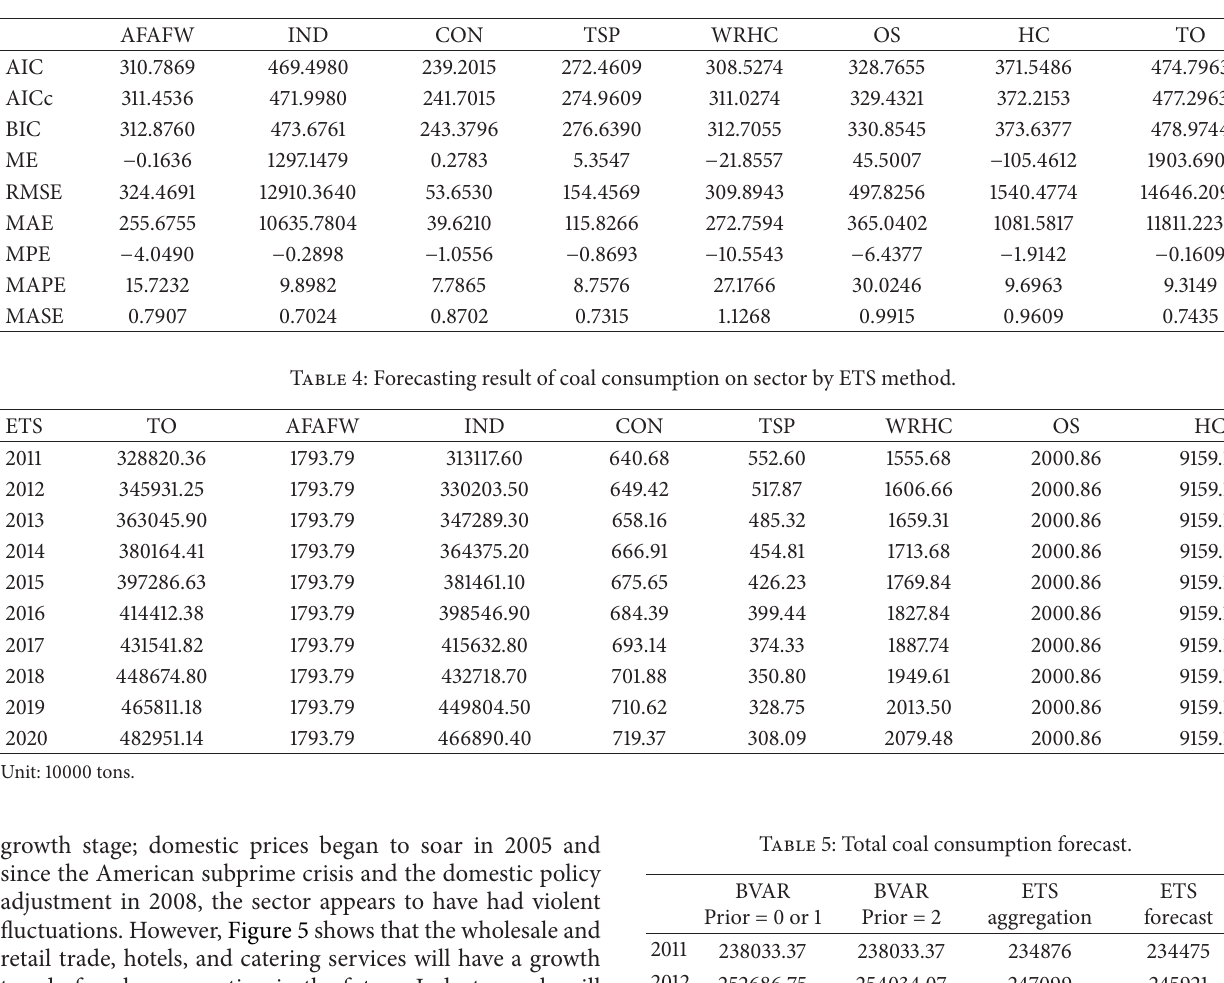
Table 3: Accuracy of forecast models on sector by ETS method.